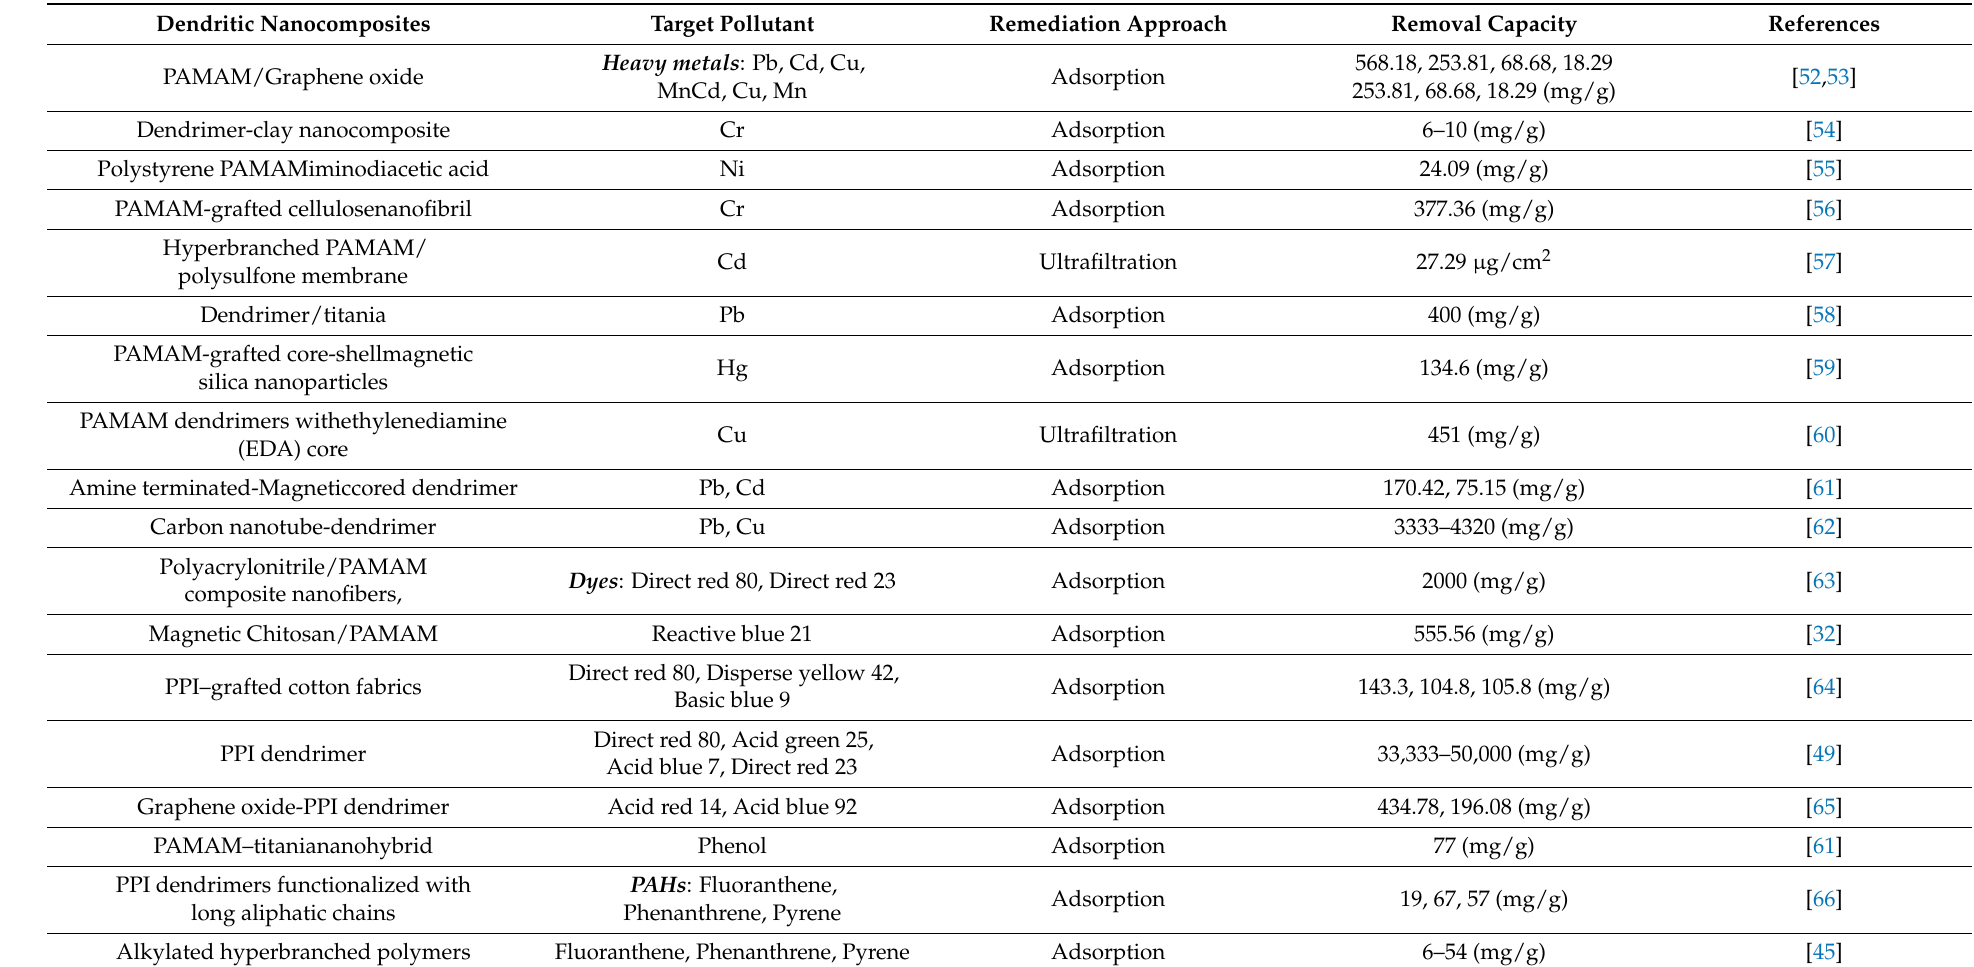
Table 1. Various dendritic polymers used for the treatment of contaminated